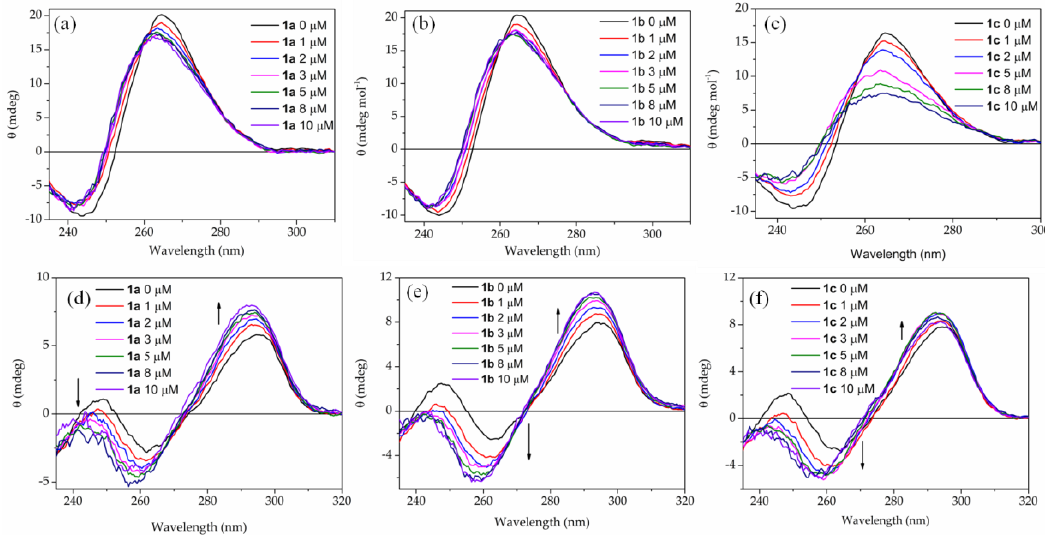
Figure 4. CD titration of c-myc (2 μM) with ( a ) 1a , ( b ) 1b , ( c ) 1c and 22CTA (2 μM) with ( d ) 1a , ( e ) 1b , ( f ) 1c . CD spectra were recorded in 10 mM lithium cacodylate buffer (pH 7.3), 90 mM LiCl, and 10 mM KCl.